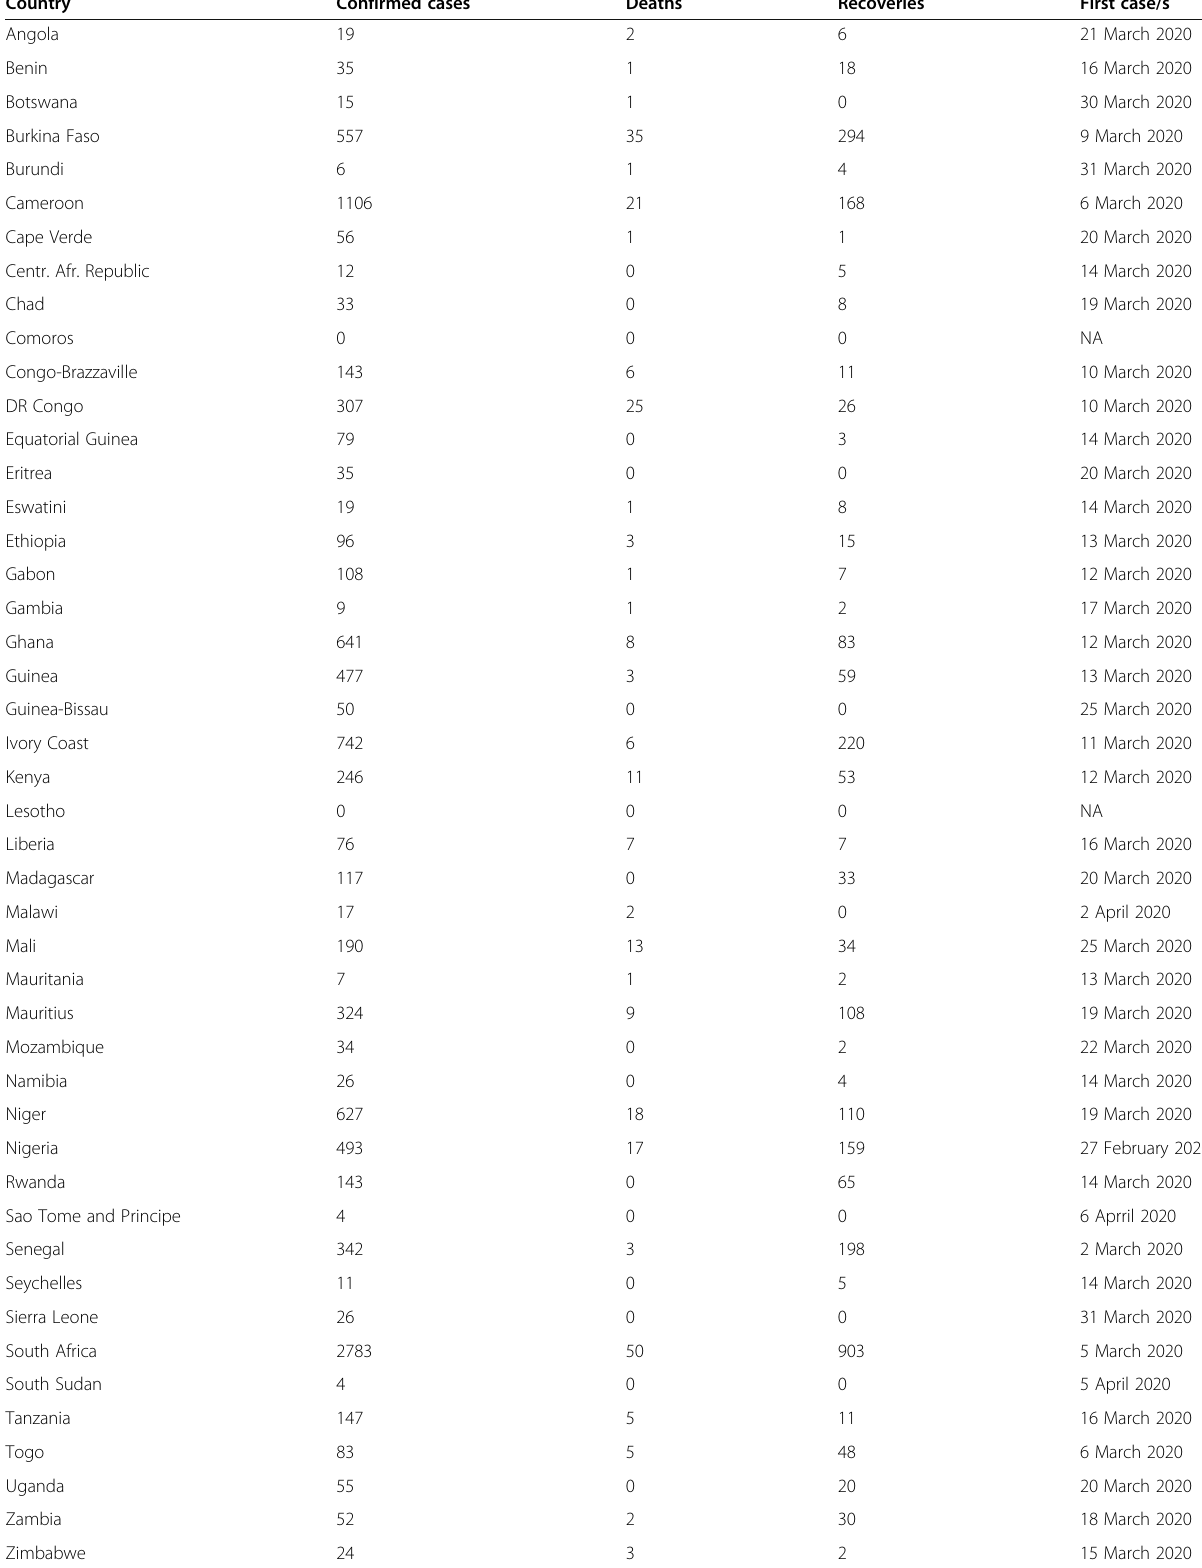
Table 2 Epidemiology of COVID-19 cases in Africa as of 18 April 2020 [32, 39] Country Confirmed